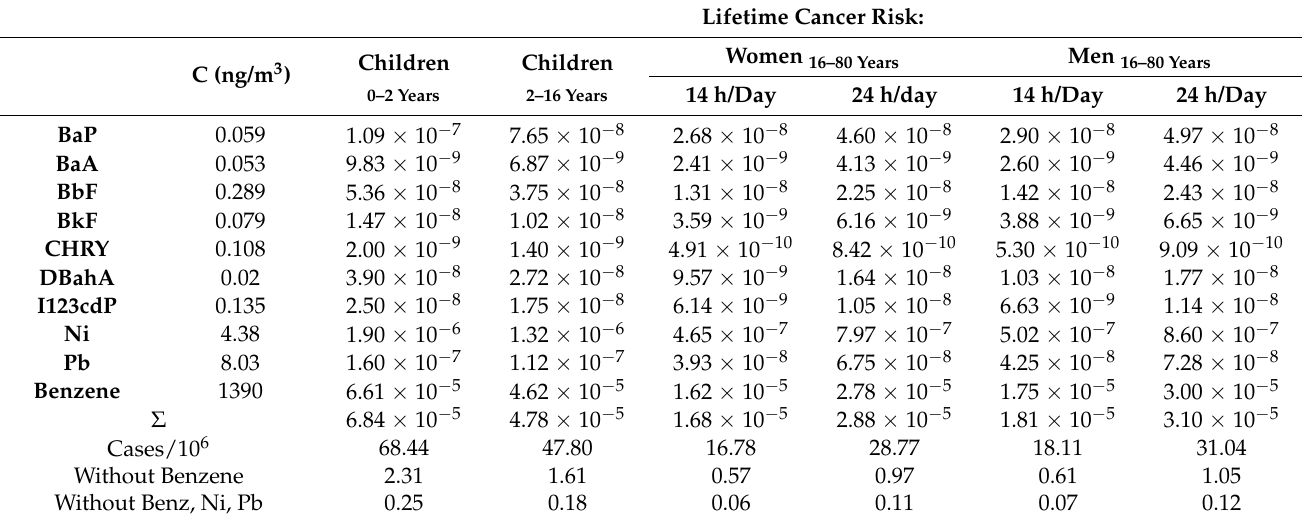
Table A14. Cancer risk assessment C.II method (Maertens, 2004/ Farris, 2014). Lifetime Cancer